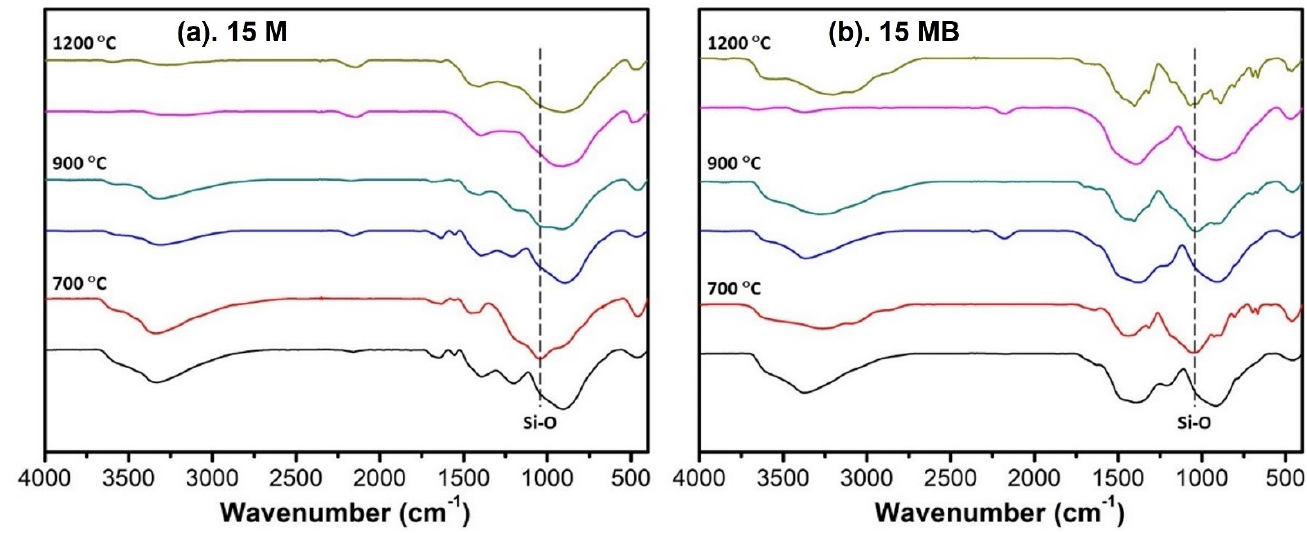
Figure 10. FTIR spectra of the moisture treatment products of the two kinds of ( a ) 15 M and ( b ) 15 MB precursors. Table 3. Air oxidation of the 15 M and 15 MB ceramic